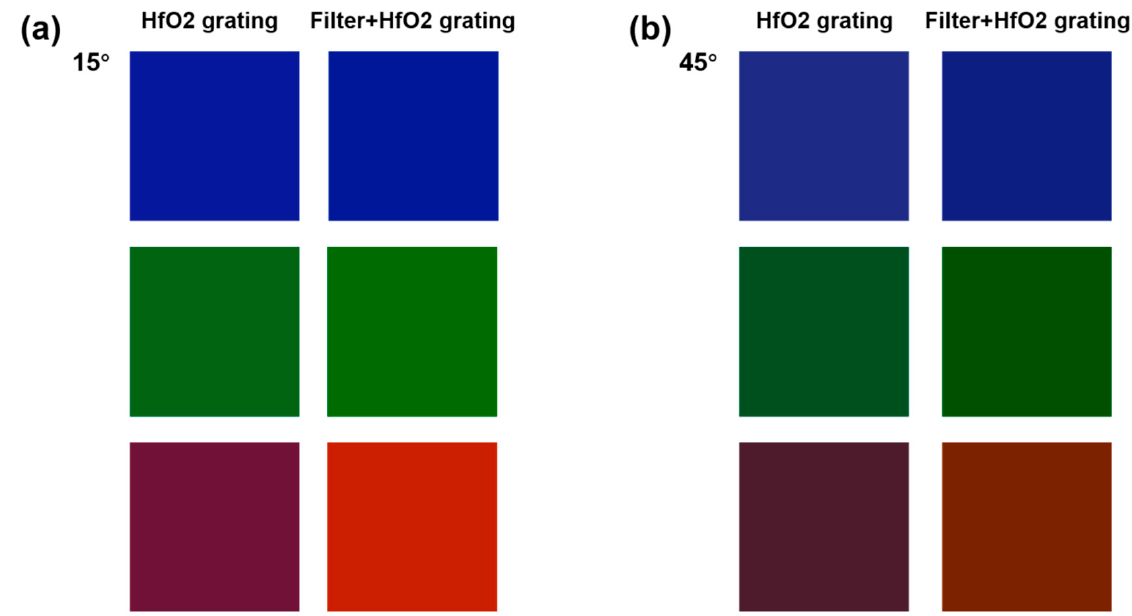
Figure 6. ( a , b ) are the blue, green and red obtained by incident on the HfO 2 grating and the “filter + HfO 2 grating” at 15° and 45° incident angles, respectively.